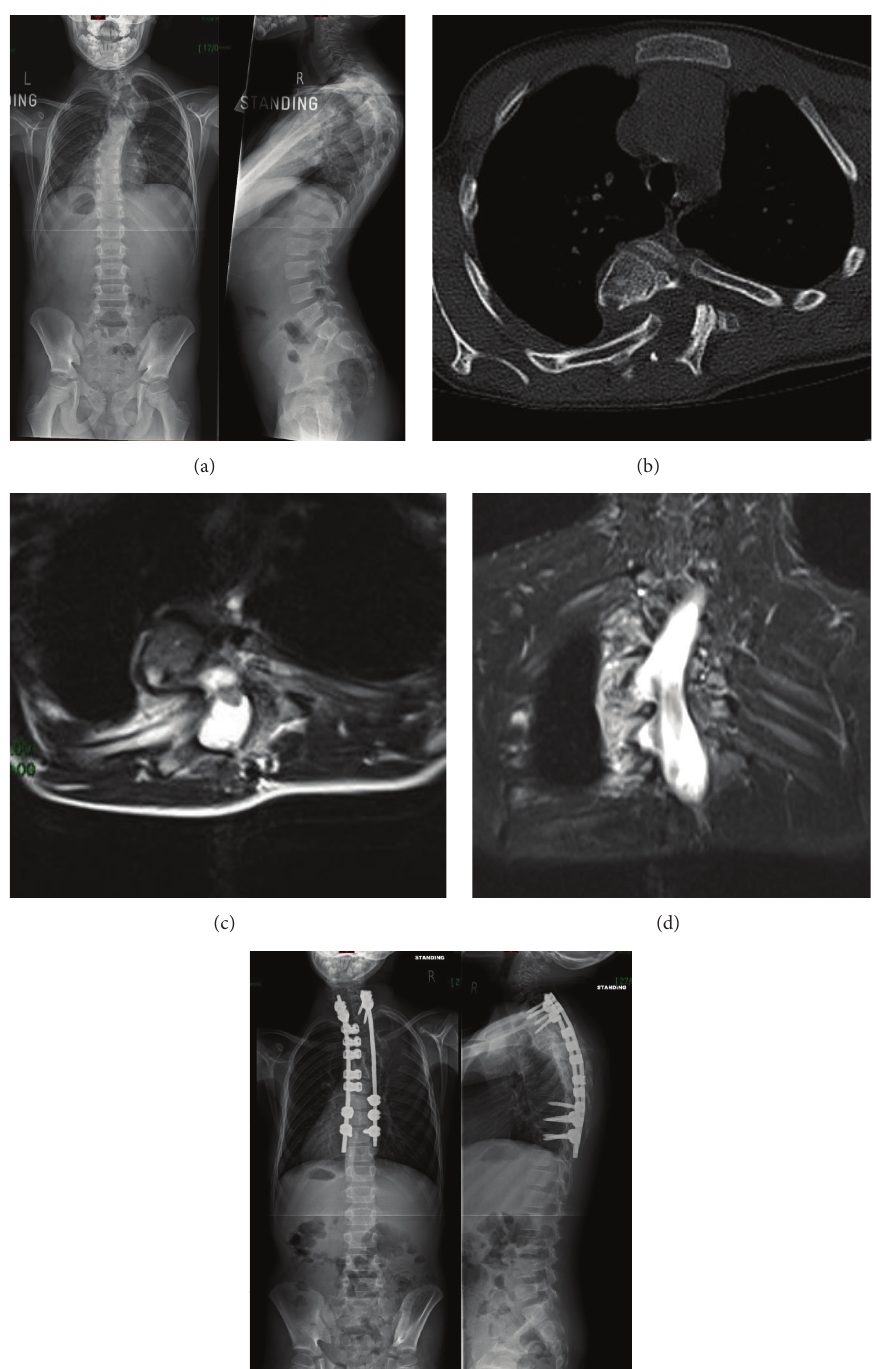
Figure 2: Preoperative whole spine AP and lateral X-ray (a). Preoperative CT scan (b) demonstrating the rib head intracanal dislocation. Preoperative sagittal T2 MRI axial (c) and coronal (d) views demonstrating the rib head in close proximity to the cord but without impingement. Postoperative whole spine AP and lateral X-rays